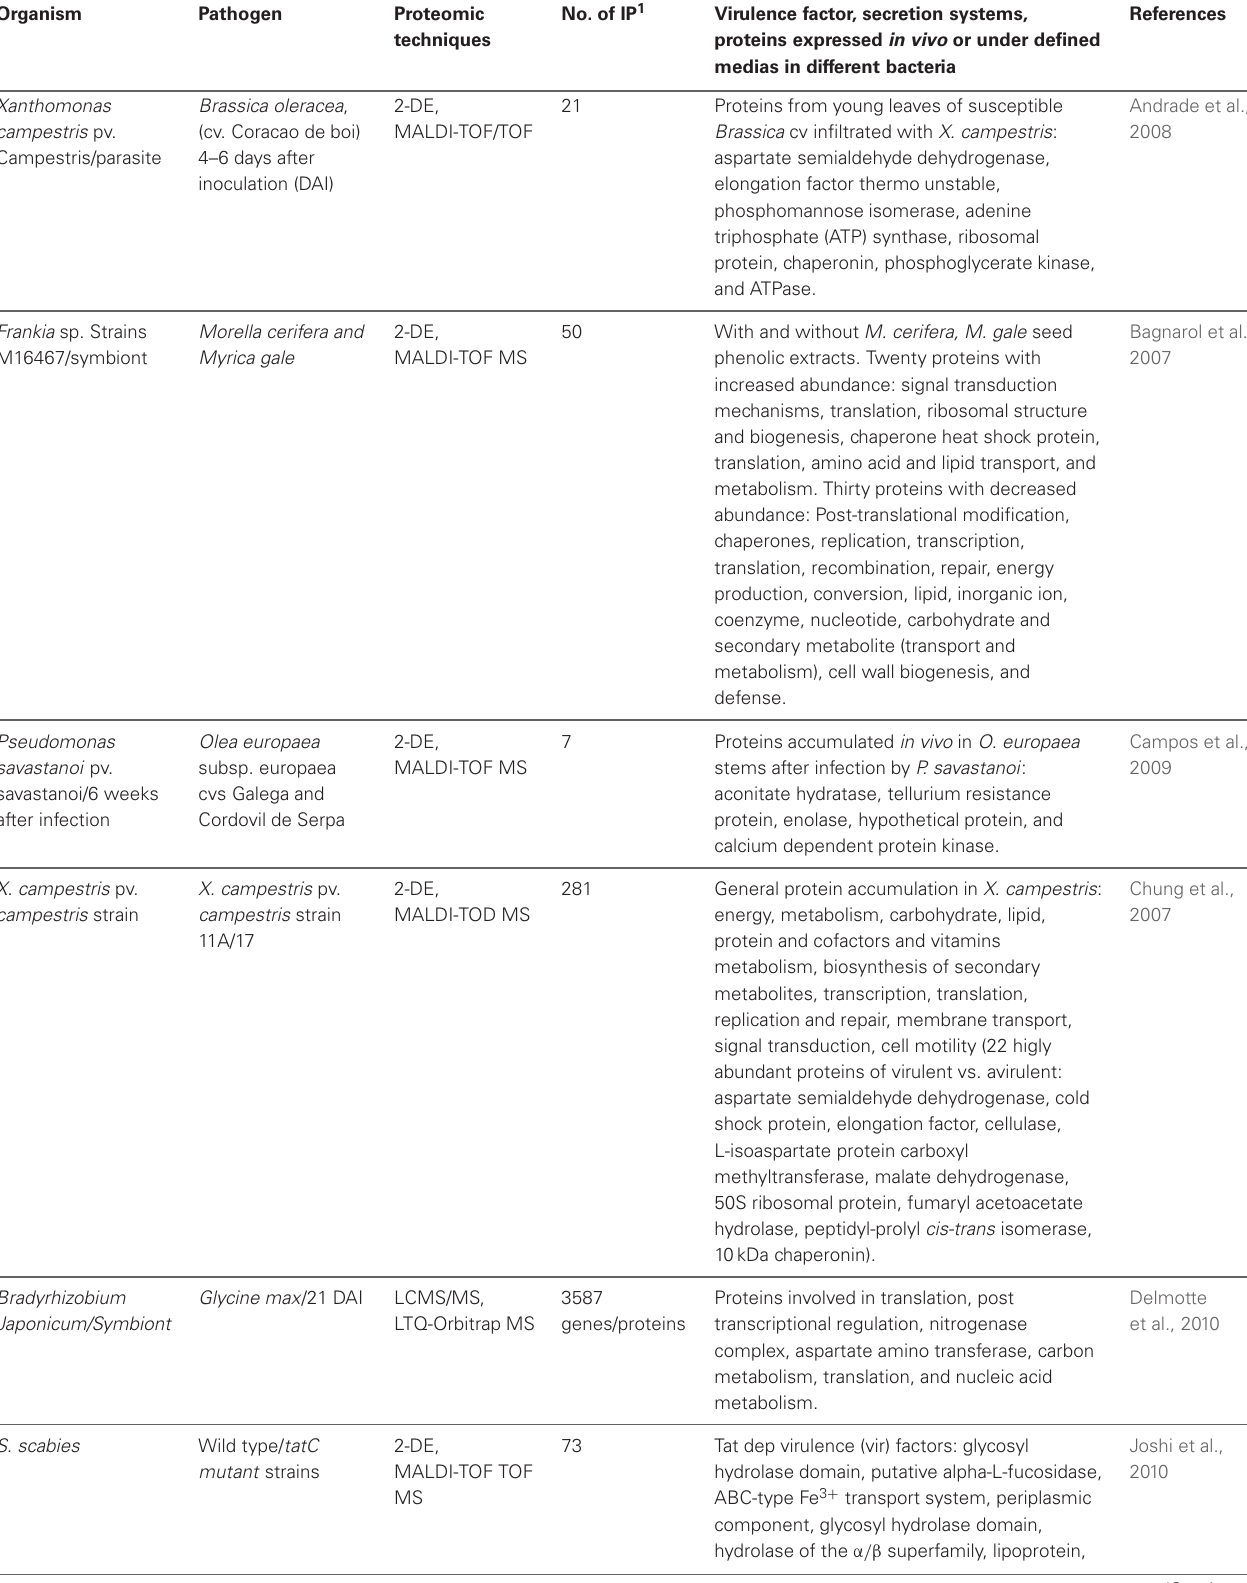
Table 1 | Expression profiling of bacterial strains in differential medias/plant associated bacteria as pathogens, symbiotic or epiphytes.